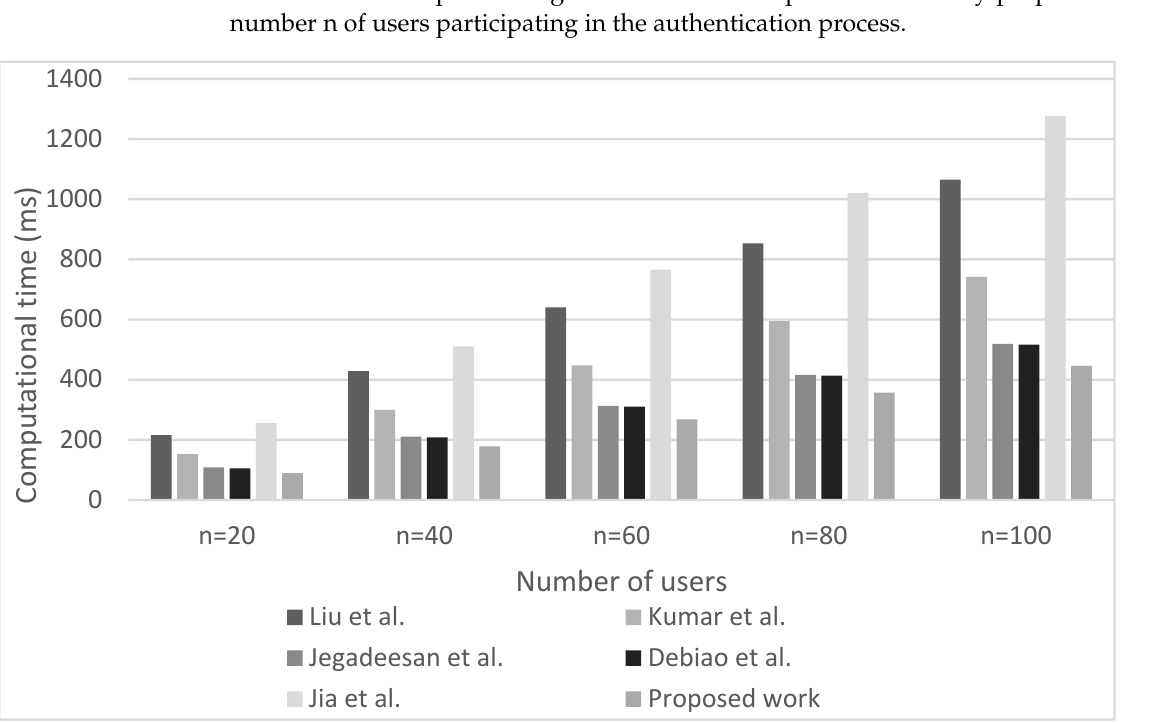
Figure 2. Computation overhead of analyzed authentication schemes at the patient’s side (Liu at al. [49], Kumar at al. [44], Jegadeesan et al. [50], Debiao et al. [51] and Jia at al.